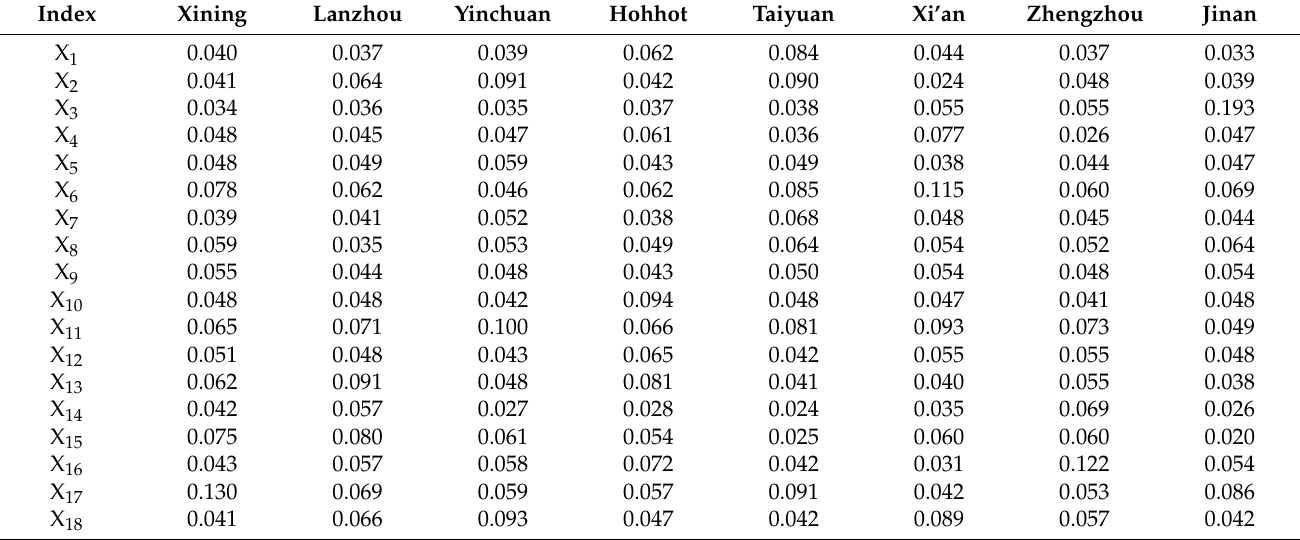
Table 2. Evaluation index weights for SLU in central cities of the Yellow River Basin, China.